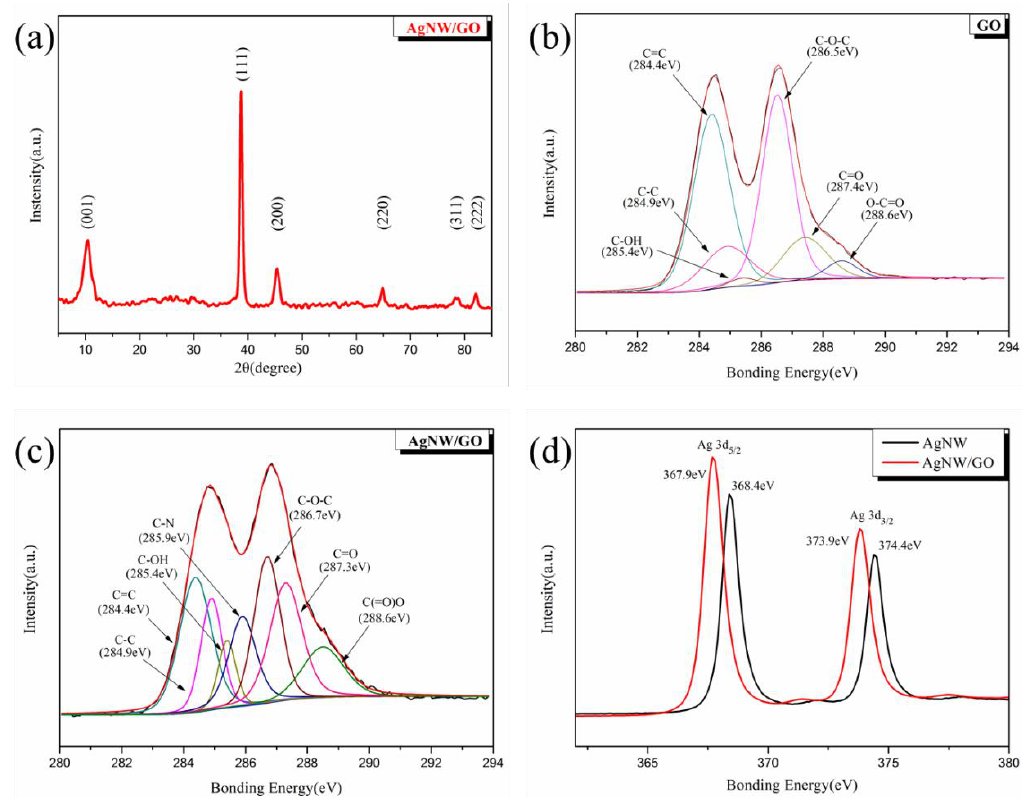
Figure 4. ( a ) Characteristic XRD pattern of AgNW/GO hybrid. ( b ) High resolution XPS C 1s spectra GO nanosheets. ( c ) XPS C 1s pattern of AgNW / GO hybrid. ( d ) Characteristic XPS Ag 3d patterns of of GO nanosheets. ( c ) XPS C 1s pattern of AgNW/GO hybrid. ( d ) Characteristic XPS Ag 3d patterns AgNWs and AgNW / GO of AgNWs and AgNW/GO hybrid.